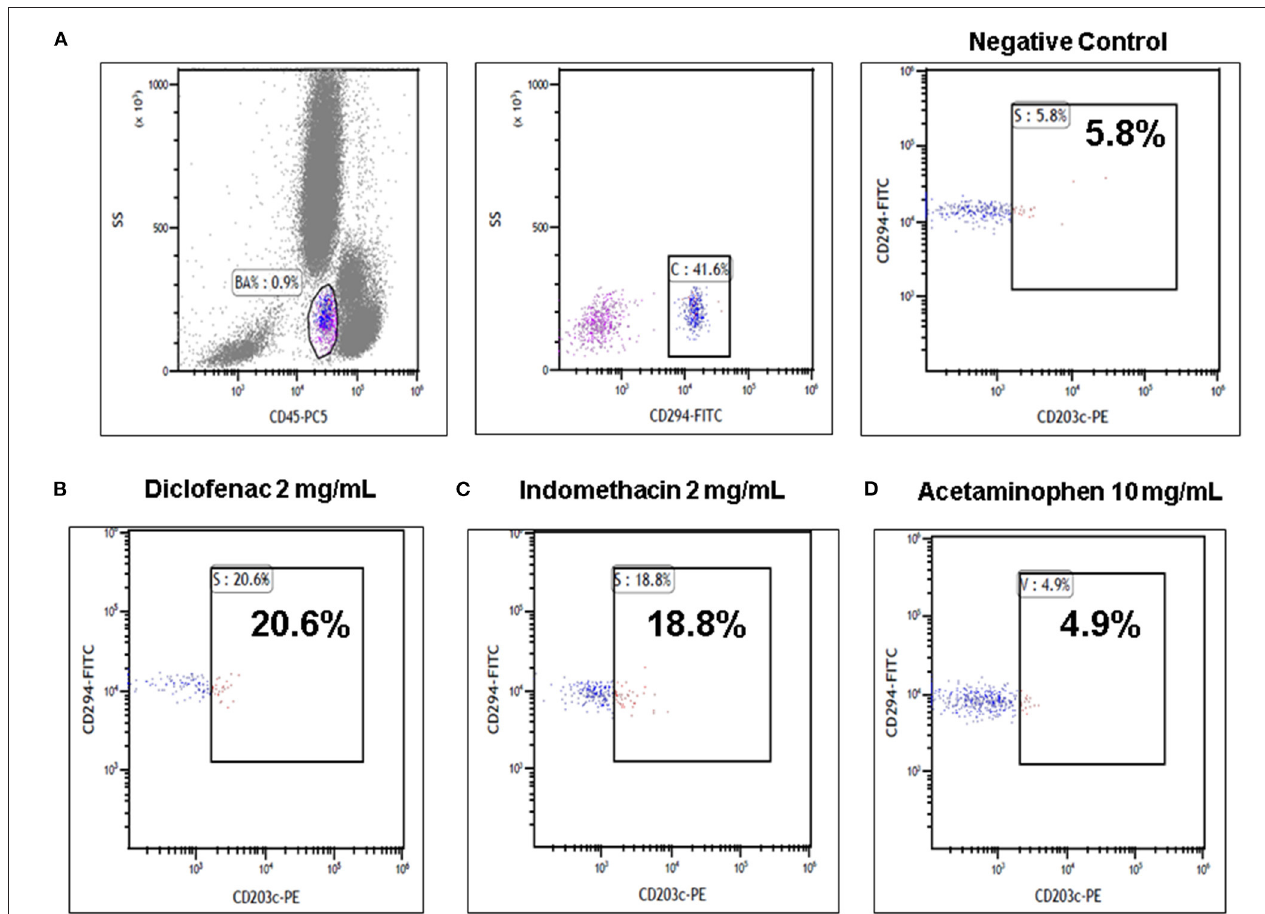
FIGURE 1 | Basophil activation tests (BATs) by flow cytometry in the diclofenac anaphylactic patient. (A) Representative images using the basophil activation marker CD203c gating strategy showing positive results of BAT with (B) diclofenac (2 mg/ml) and (C) indomethacin (2 mg/ml) and negative results of BAT with (D) acetaminophen (10 mg/ml) are